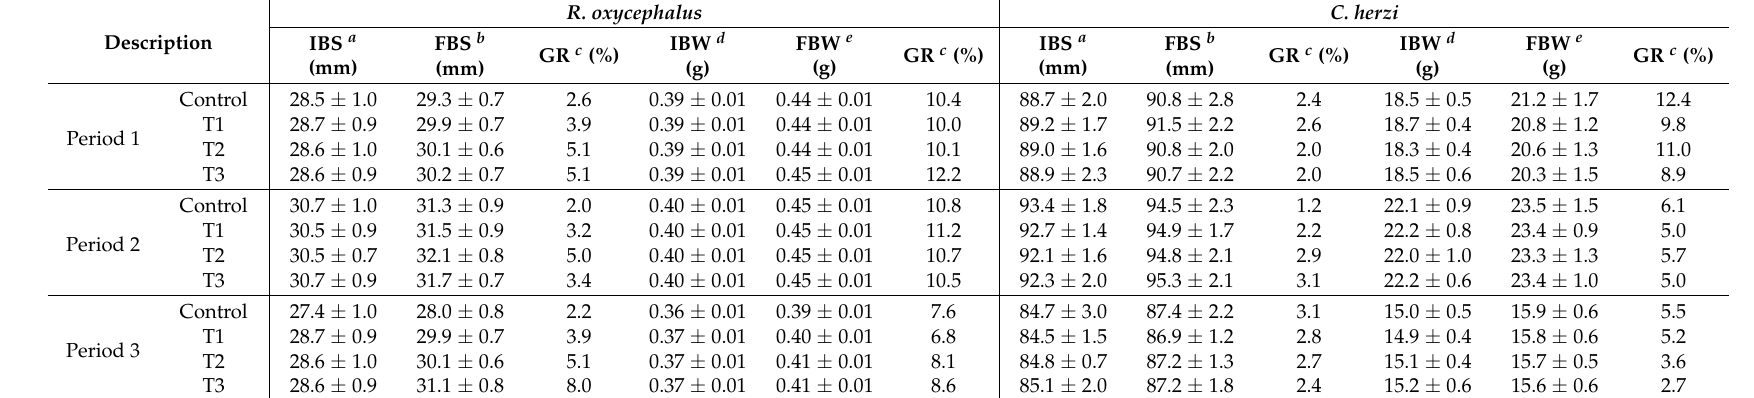
Table 3. Changes in body size and weight of both prey ( R. oxycephalus ) and predator ( C. herzi ) fish during each experimental